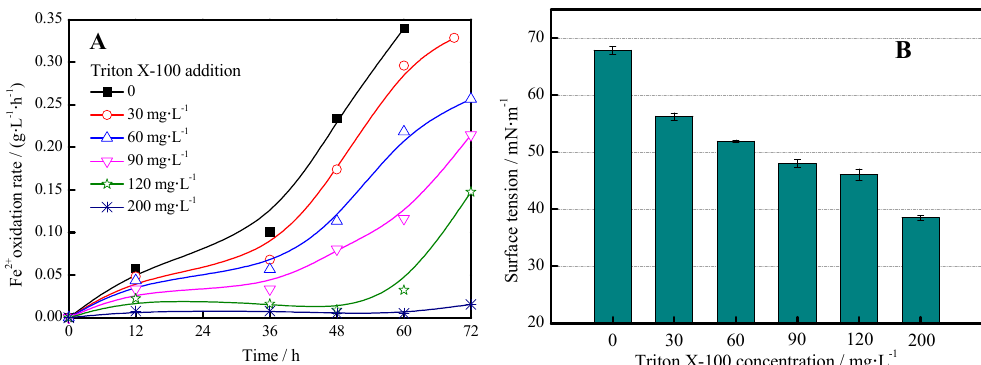
Figure 2. Influences of Triton X-100 on iron-oxidizing activity of At. ferrooxidans and on the surface tension of solution: ( A ) bacteria inoculation 10% ( v / v ), initial Fe 2+ 8.9 g·L − 1 , initial pH 2.0, rotational speed 160 rpm, and temperature 30 °C; ( B ) Fe 2+ 0 g·L − 1 , pH 2.0, and temperature 30 °C.